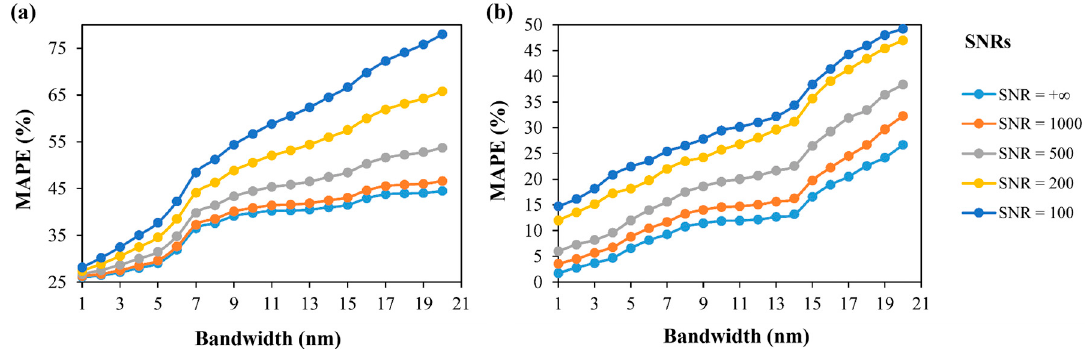
Figure 13. MAPE (%) of transfer learning-based DNN-predicted composition results at different bandwidths and SNRs: ( a ) species level, ( b ) community level.